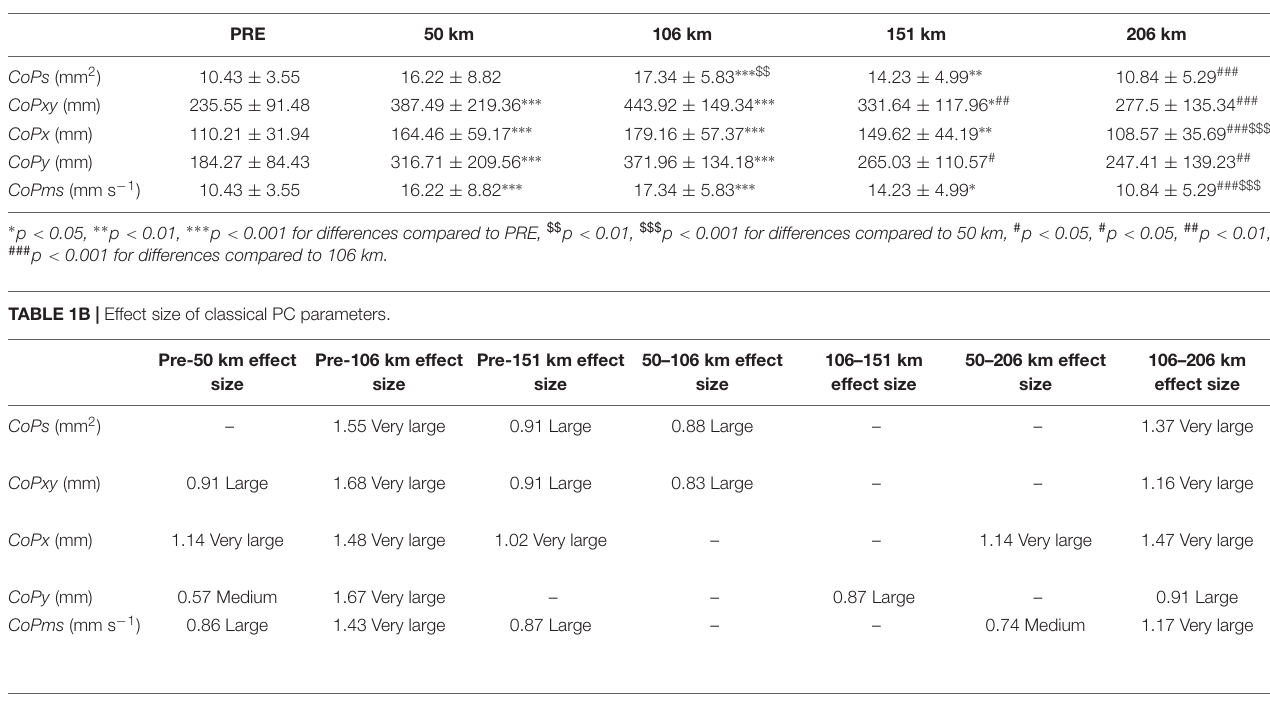
TABLE 1A | Results (mean ± SD) of standard postural control (PC) parameters represented by surface ( Co Ps), total displacement (C o Pxy), Anteroposterior displacement (C o Py), mediolateral displacement (C o Px), mean speed (C o Pms) during the condition PRE and every 50 km.